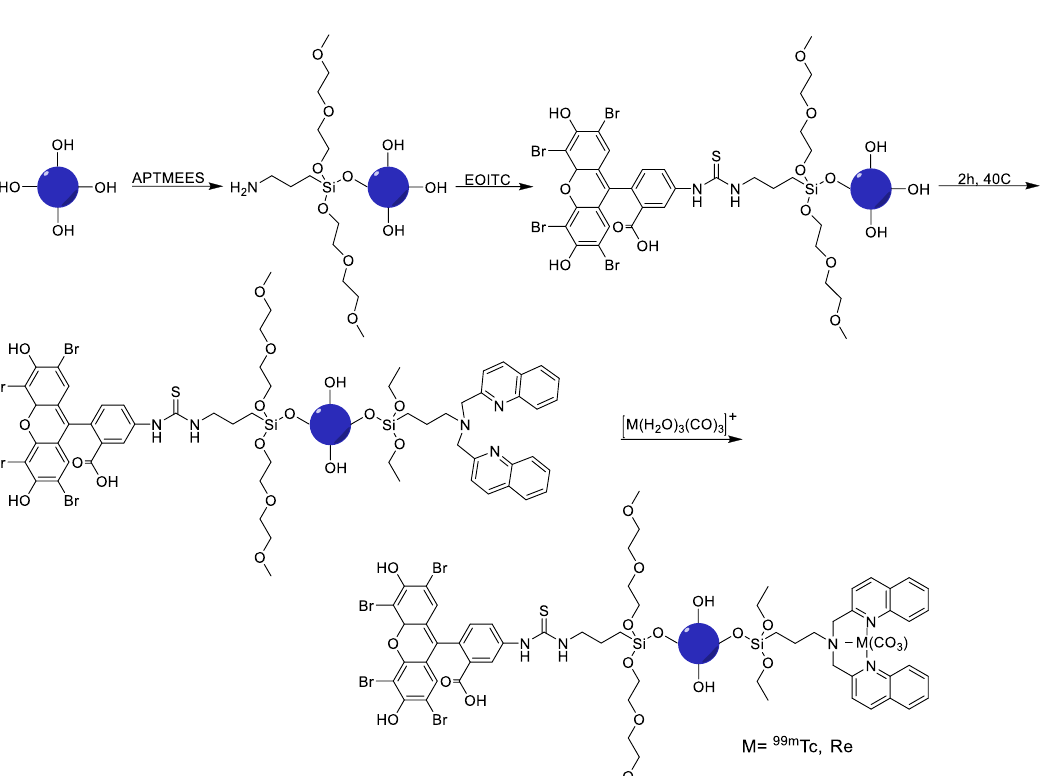
Figure 10. Schematic diagram for the synthesis of the 99m Tc-MnO-MSNs-PEG nanodrug [56].